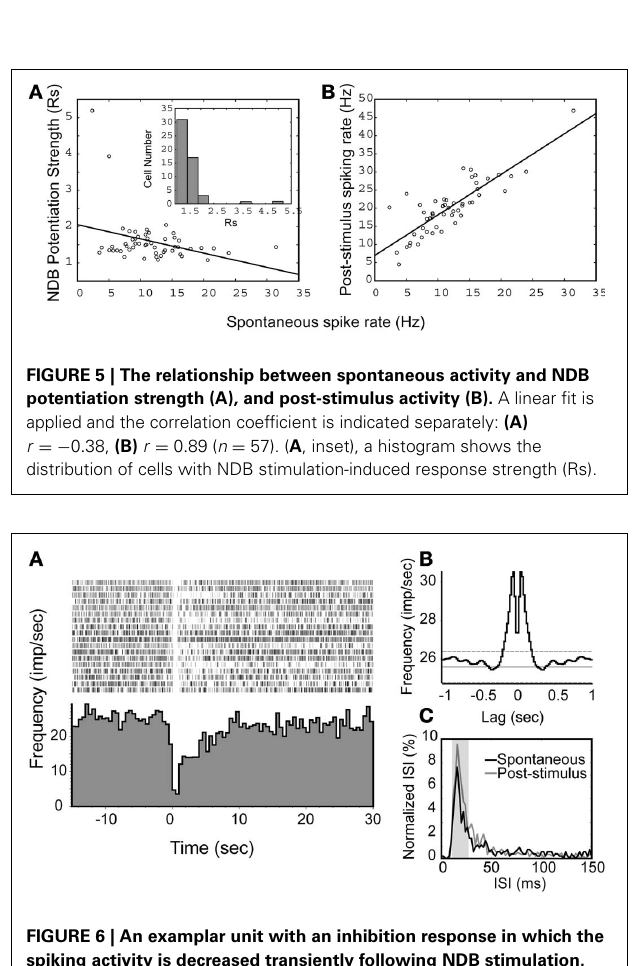
FIGURE 6 | An examplar unit with an inhibition response in which the spiking activity is decreased transiently following NDB stimulation. (A) Peri-stimulus histogram and raster plot show the decreased spiking with an average of spontaneous spike rate at 26 spikes/s. (B) Autocorrelation of spontaneous spikes. Bin = 20ms. (C) The ISIs of this unit are elevated at 10–25ms. 1999; Ghatpande et al., 2006; Mandairon et al., 2006; Pressler